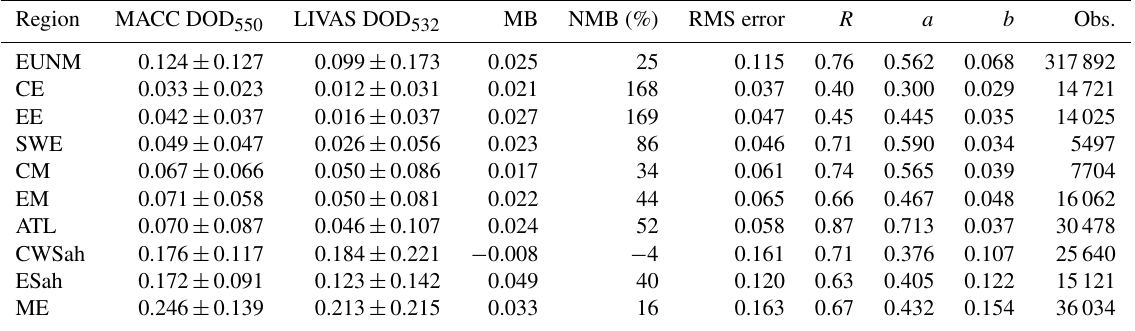
Table 1. MACC DOD 550 ( ± 1 σ ) and LIVAS DOD 532 ( ± 1 σ ) levels, MACC–LIVAS MB, NMB and RMS error, slope, and intercept of the MACC–LIVAS linear regression line and the corresponding correlation coefficient R for the Europe–northern Africa–Middle East (EUNM) domain and for the nine subregions of